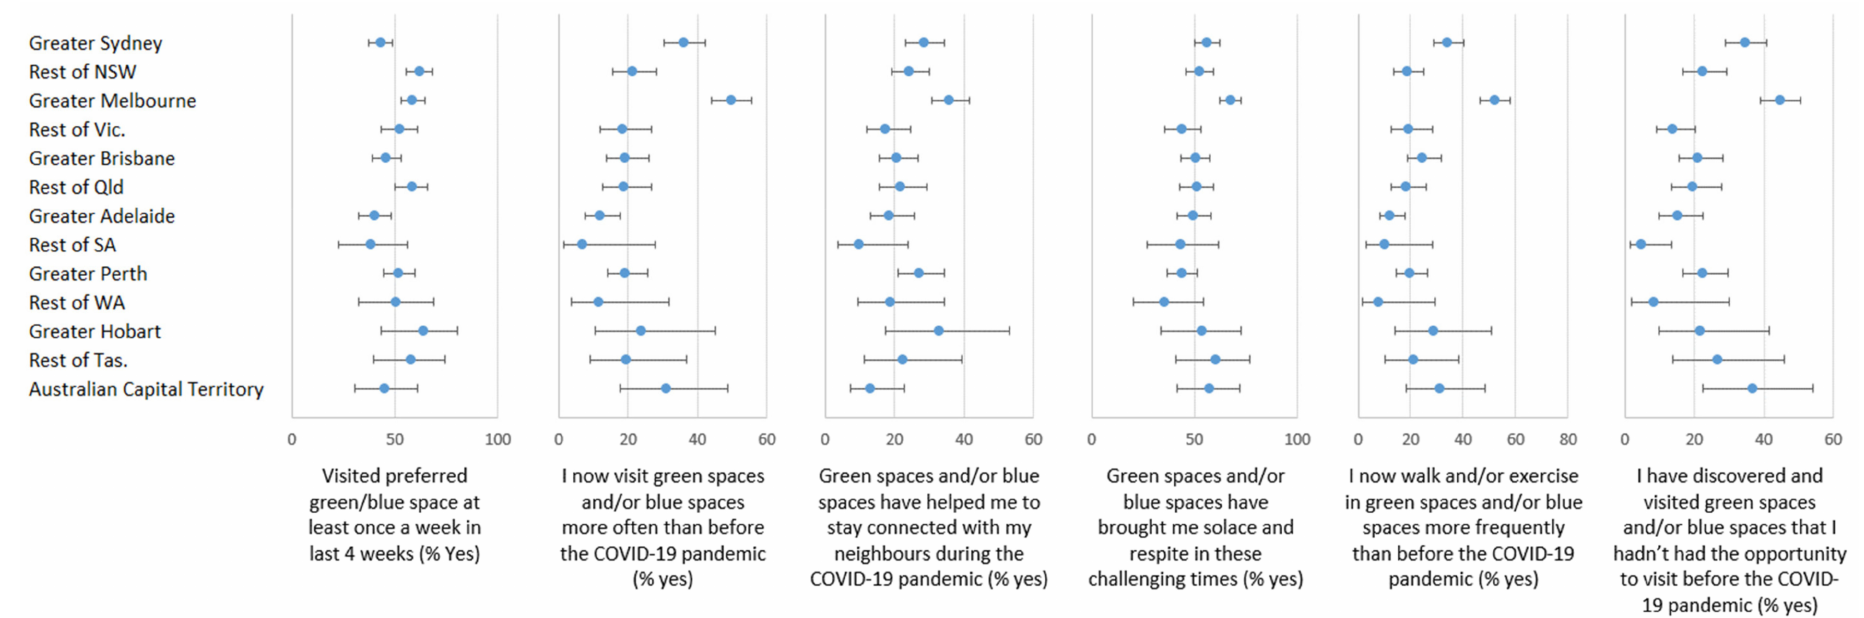
Figure 2. Geographical differences in access to and visitation, changes in visits and felt benefits of preferred green or blue spaces during the COVID-19 pandemic (weighted for representativeness, unadjusted for